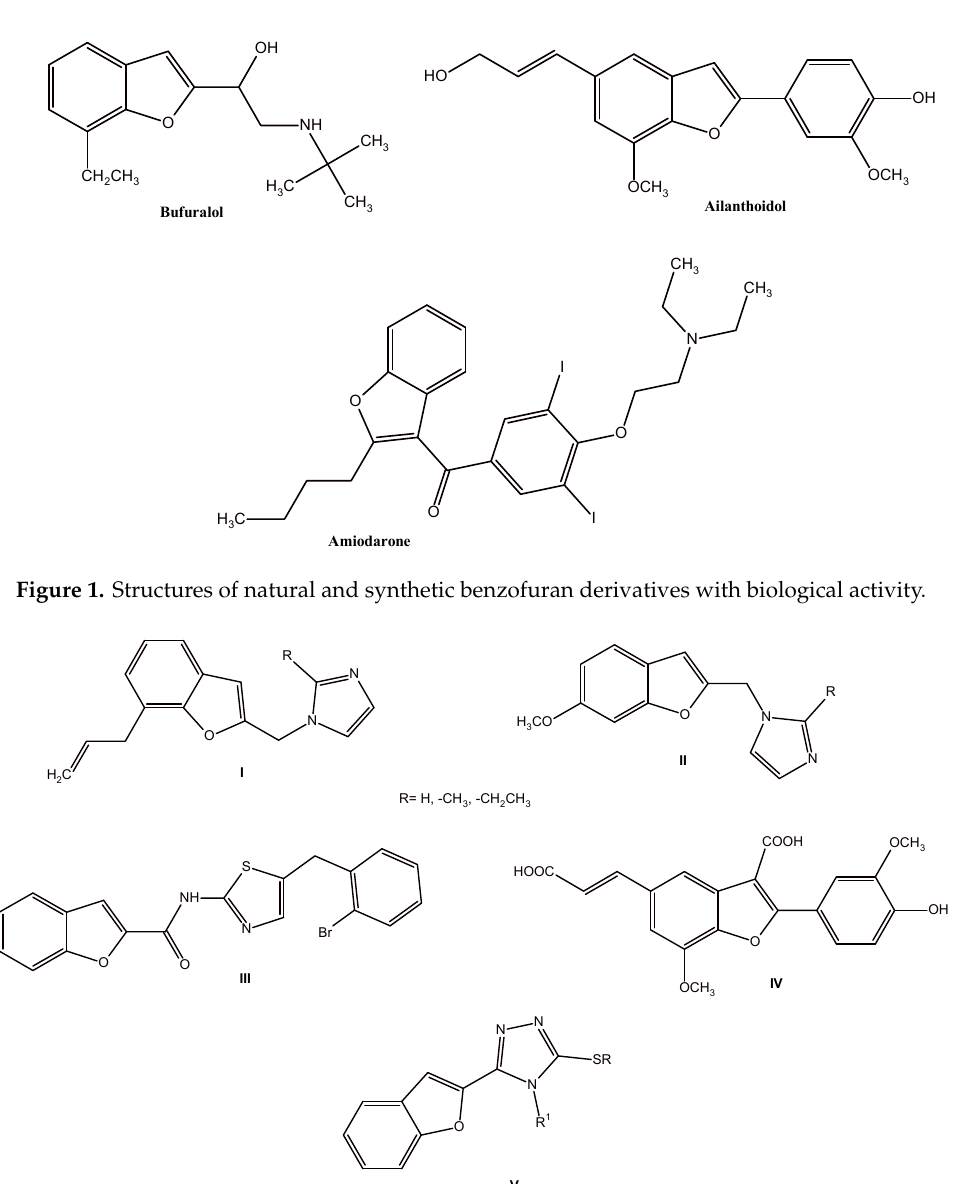
VII Figure 3. Structures of 2- and 3-benzofurancarboxylic acid derivatives VI–VII with cytotoxic activity. The literature survey shows that benzofurans containing halogens in their structure constitute an important group of compounds, with antitumor, cytotoxic, spasmolytic, antiarrhythmic, and antifungal activity [9–20]. Thus, this group of compounds is interesting for researchers, especially because the presence of halogen can increase the activity and selectivity of derivatives. This is probably related to the ability of halogens to create a “halogen bond”, which results from the formation of the σ -hole. Although the halogen bonds are weaker than hydrogen bonds, they have specific effects and can lead to significant gains in binding affinity. These interactions can be found in protein-receptor complexes as well as in small molecules [21–24].